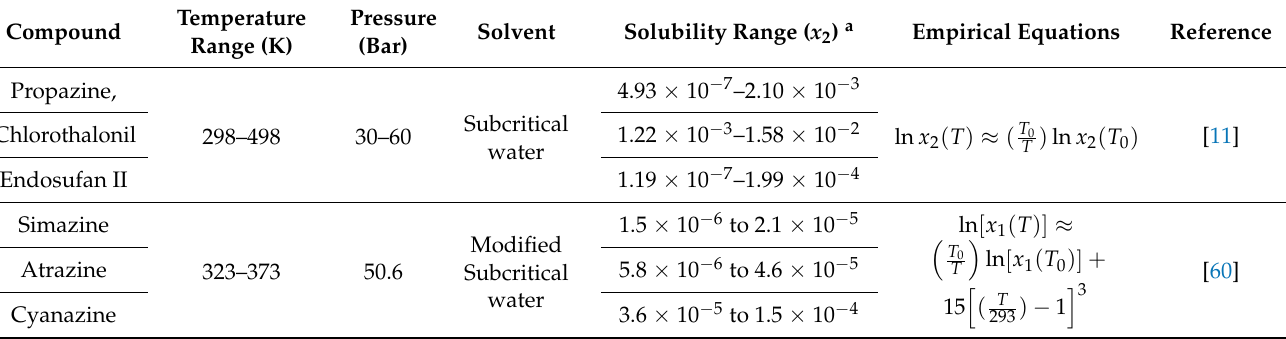
Table 7. Pesticide solubilities in subcritical